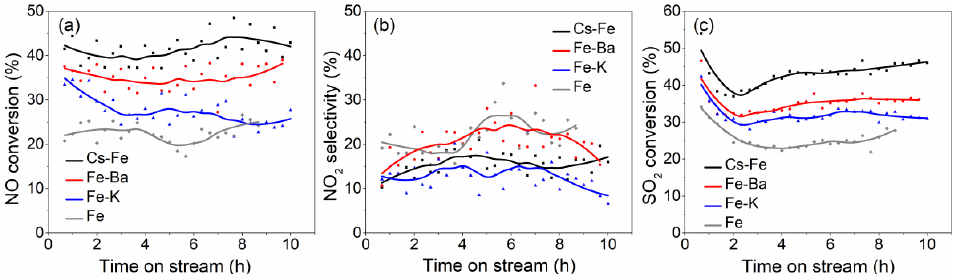
Figure 4. SO 2 resistance of promoter-doped Fe-HZSM-5 at 350 °C: ( a ) NO conversion; ( b ) NO 2 selectivity; ( c ) SO 2 removal. Reaction temperature of 350 °C, NO = 1000 ppm, SO 2 = 500 ppm, O 2 = 10 vol.% with N 2 as balance gas, GHSV = 15,000 h − 1 .